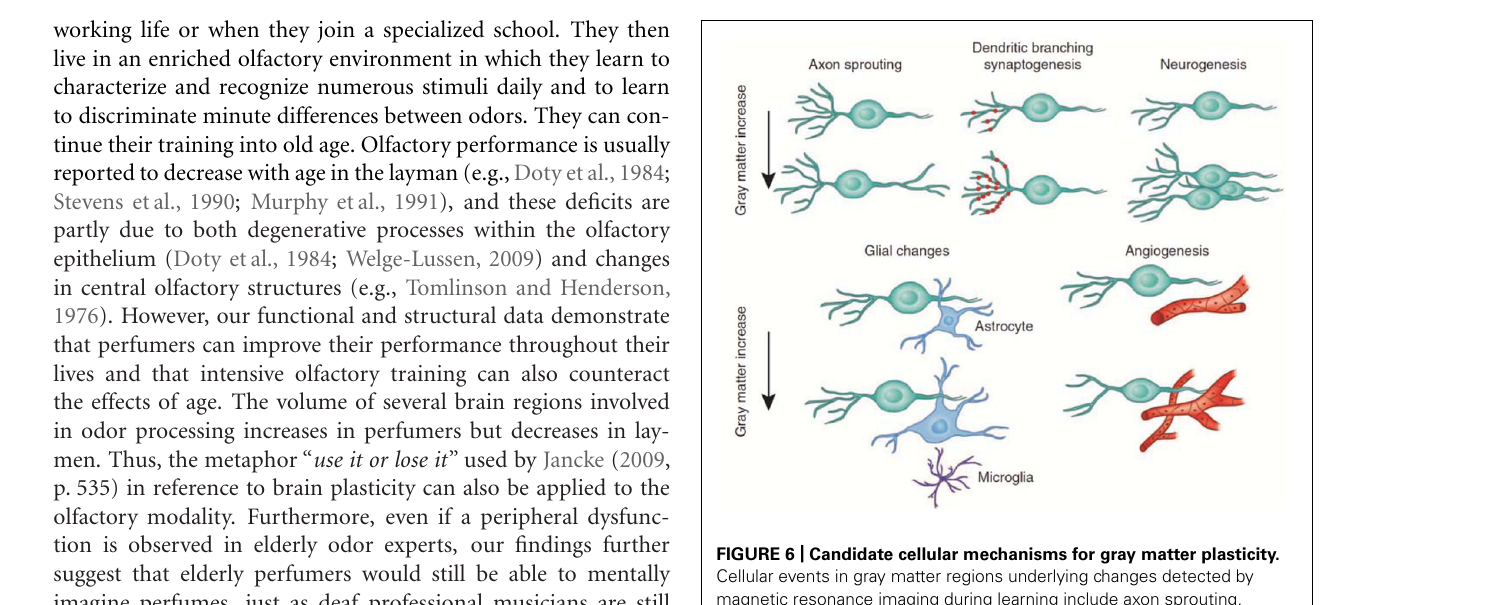
olfactory learning in rats is accompanied by a dendritic spine density increase (15%) along apical dendrites of pyramidal